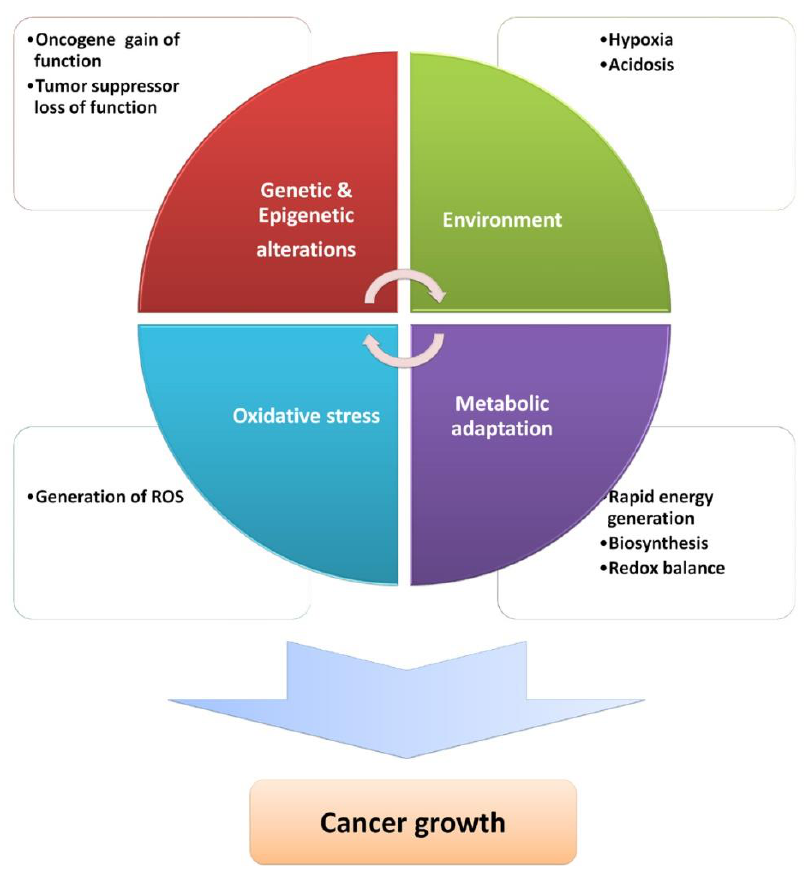
Figure 3. Interconnected cancer-growth-supportive alterations and factors.